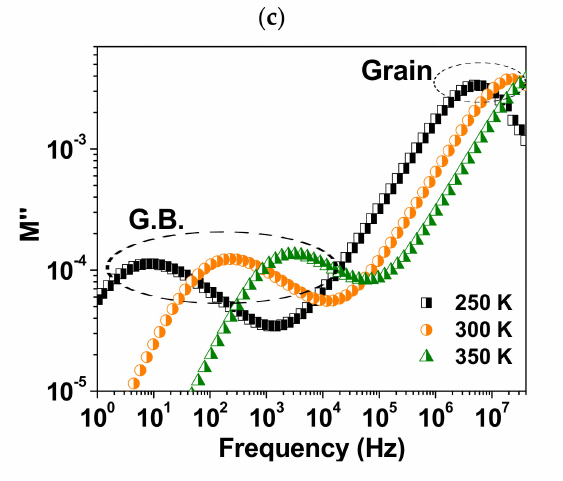
Figure 9. Frequency dependence of M” at different temperatures for ( a ) BCTO-950, ( b ) BCTO-975, and ( c ) BCTO-990 ceramic samples.